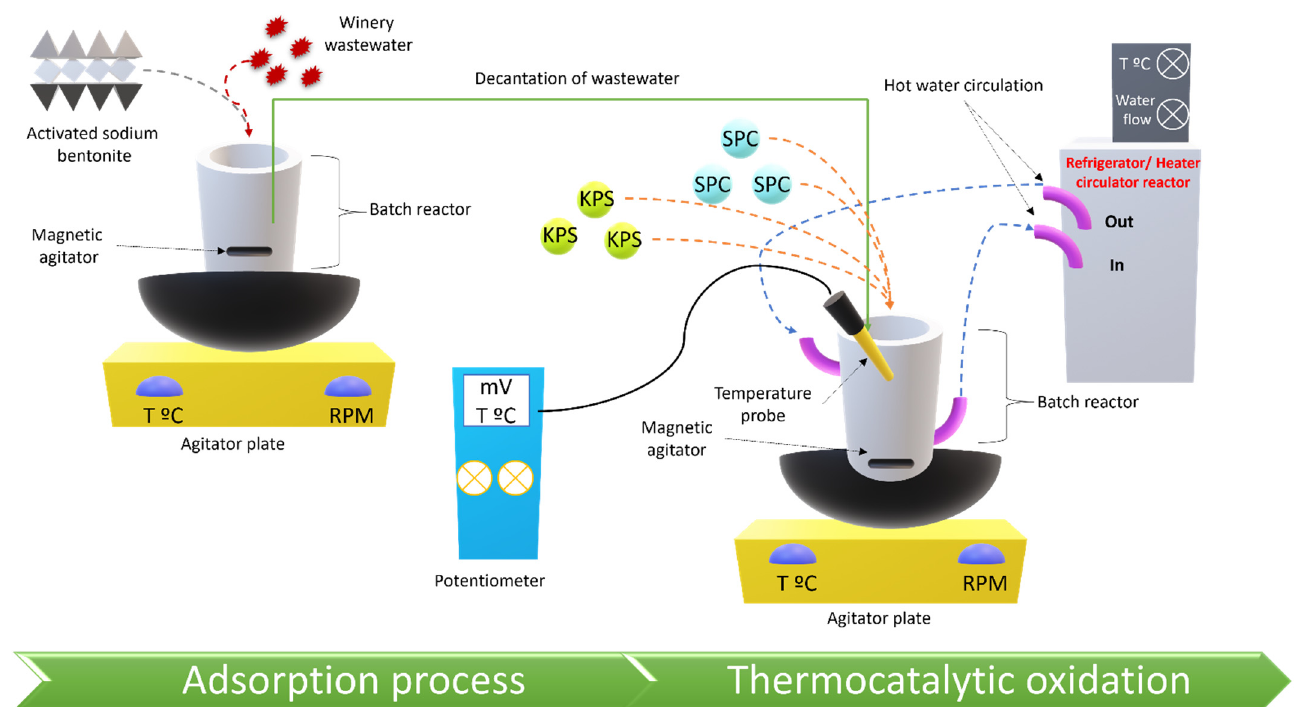
Figure 2. Illustration of the adsorption and thermocatalytic oxidation processes.